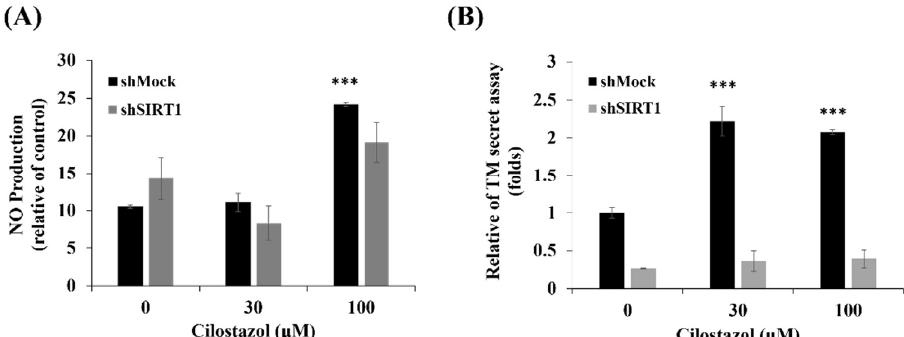
Figure 7. The NO production and TM secretion on cilostazol-treated shSIRT1 cells. HUVECs, shMock, or shSIRT1 were cultured with 0, 30, and 100 µ M cilostazol for 24 h. ( A ) The NO production of cells was stained with 4,5-diaminofluorescein and analyzed using flow cytometry. ( B ) The TM secretion was measured using ELISA. Data are presented as mean ± SEM, n = 3. *** p < 0.001 compared to the untreated group.